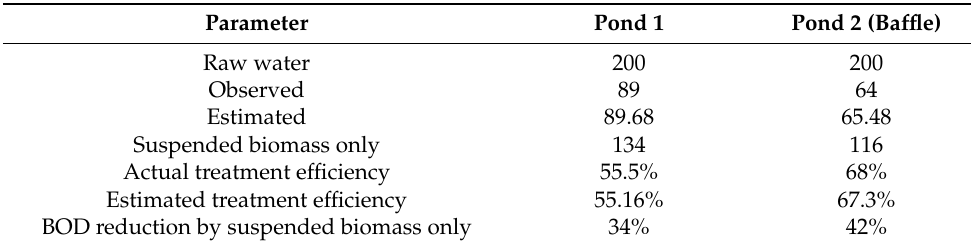
Table 3. Best computed (using Equation (2)) and observed BOD concentration of effluent (mg L − 1 ) and removal efficiency (%).